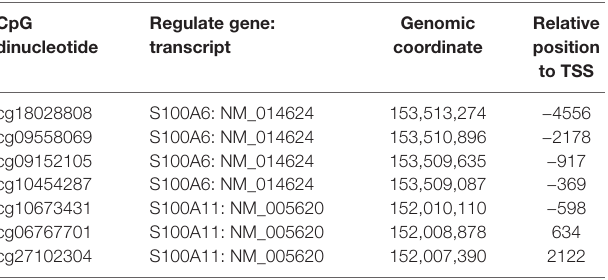
TABLE 1 | The genomic coordinates and relative positions of CpG dinucleotides